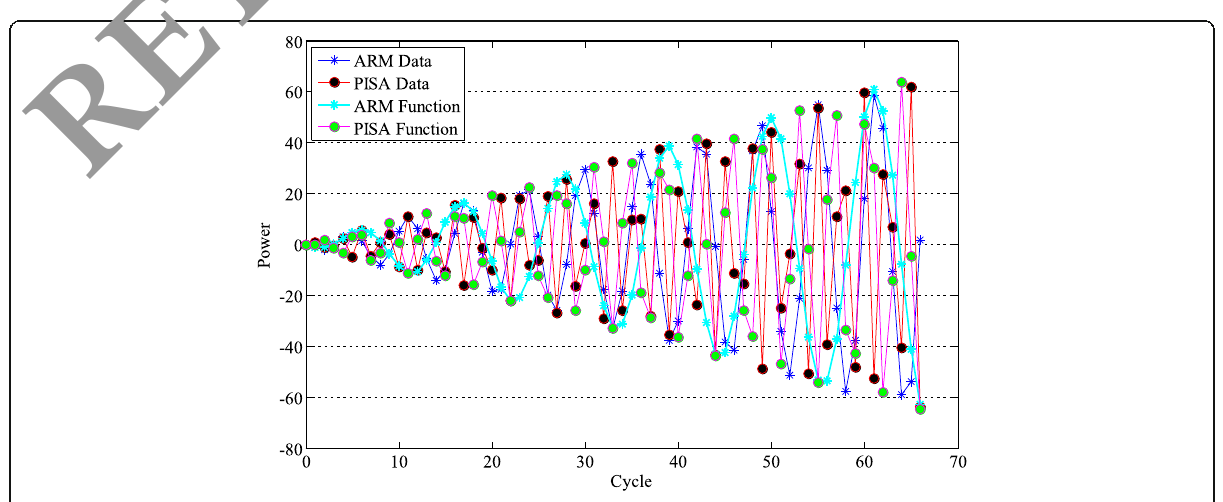
Fig. 7 Comparison of real-time power consumption of two partitioning